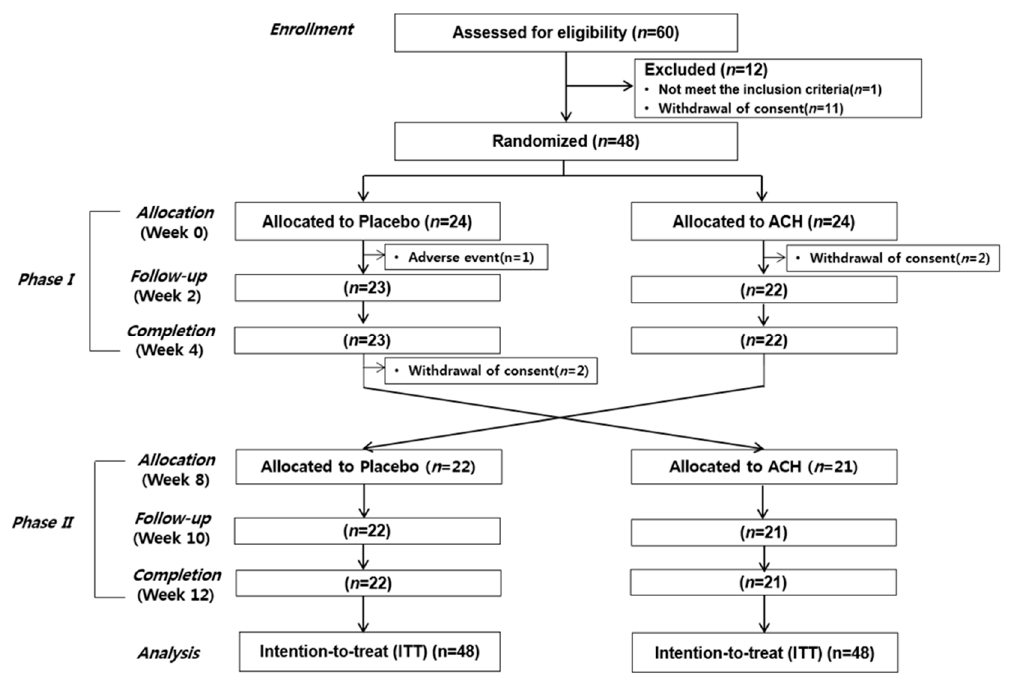
Figure 1. Study protocol. ACH, alpha-s1 casein hydrolysate.